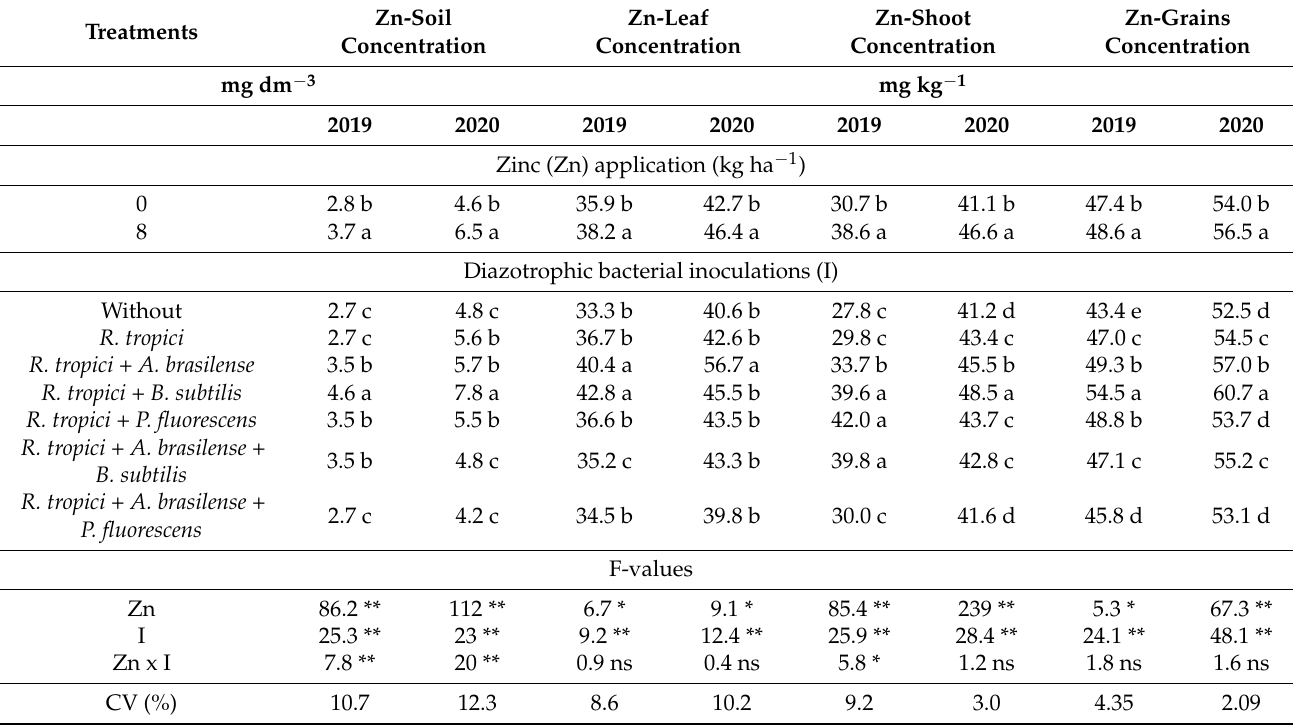
Table 2. Zinc concentration in soil, leaf, shoot, and grain of common bean under the influence of diazotrophic bacteria and soil applied zinc doses. Selv í ria—MS, Brazil, 2019 and